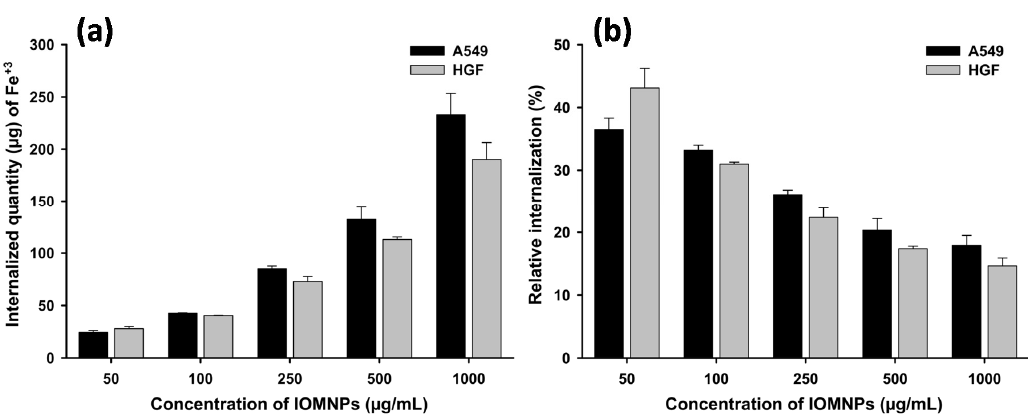
Figure 6. The amount of Fe +3 internalized in HGF and A549 ( a ) and the relative internalization ( b ) evaluated after 24 h of exposure to different concentrations of IOMNPs. The values are expressed as mean ± SD of at least three biological replicates.